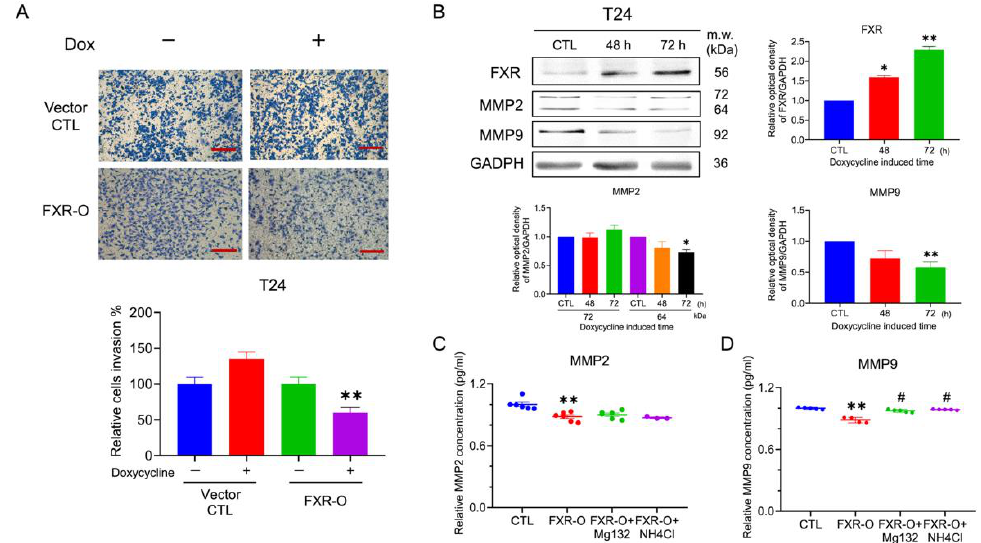
Figure 6. The effect of invasive abilities after FXR overexpression. ( A ) Transwell invasion assays were performed for 16 h incubation in the T24 cells after FXR overexpression. The invasive cells were stained and captured. The right panel displayed the quantitative result. ** p < 0.01 compared to the control group. Scale bar = 200 µ m. ( B ) The expression of matrix metalloproteinases-2 (MMP2) and matrix metalloproteinases-9 (MMP9) were analyzed by Western blotting in the T24 cells. GAPDH was used as the loading control. ( C ) The concentration levels of MMP2 in the CM of T24 cells were analyzed by ELISA. ( D ) The protein activity of MMP9 in the CM of T24 cells were analyzed by the Fluorokine assay. * p < 0.05; ** p < 0.01 compared with the control group. # p < 0.05 compared to the FXR-O